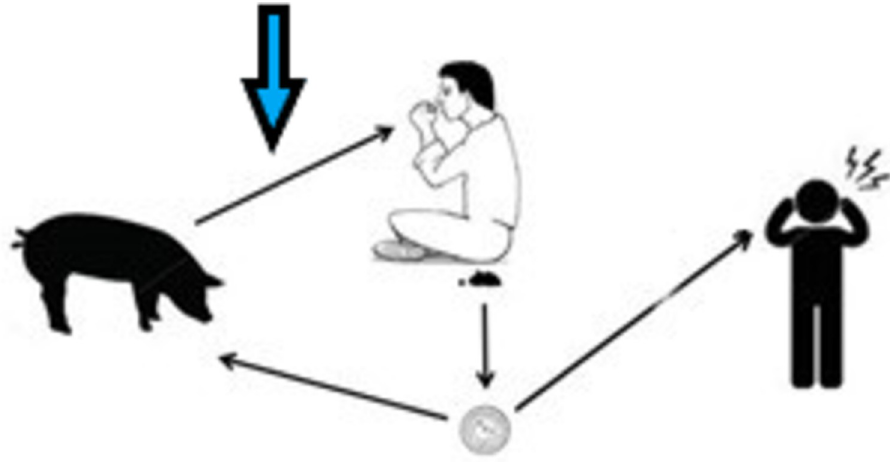
Fig 1. The (simplified) life cycle of Taenia solium , modified from [7]. T . solium eggs are shed by infected humans and passed on to humans or pigs through ingestion of faecal matter, causing (neuro)cysticercosis. If infected pork is consumed, humans can develop taeniosis, thus completing the